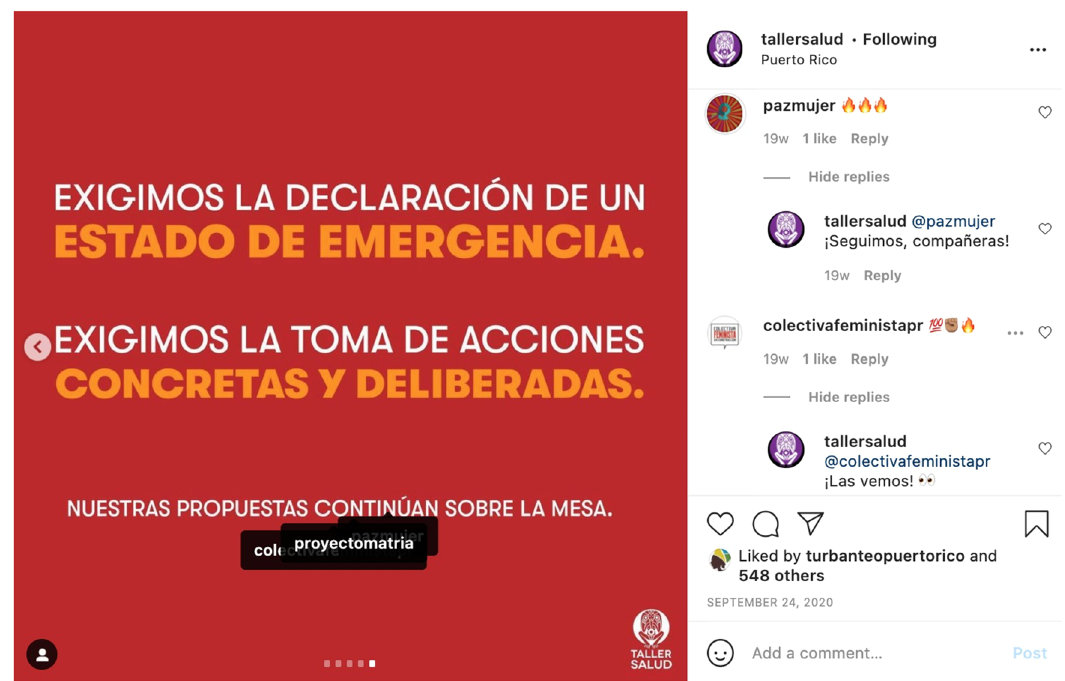
Figure 5: Screenshot from Taller Salud Instagram